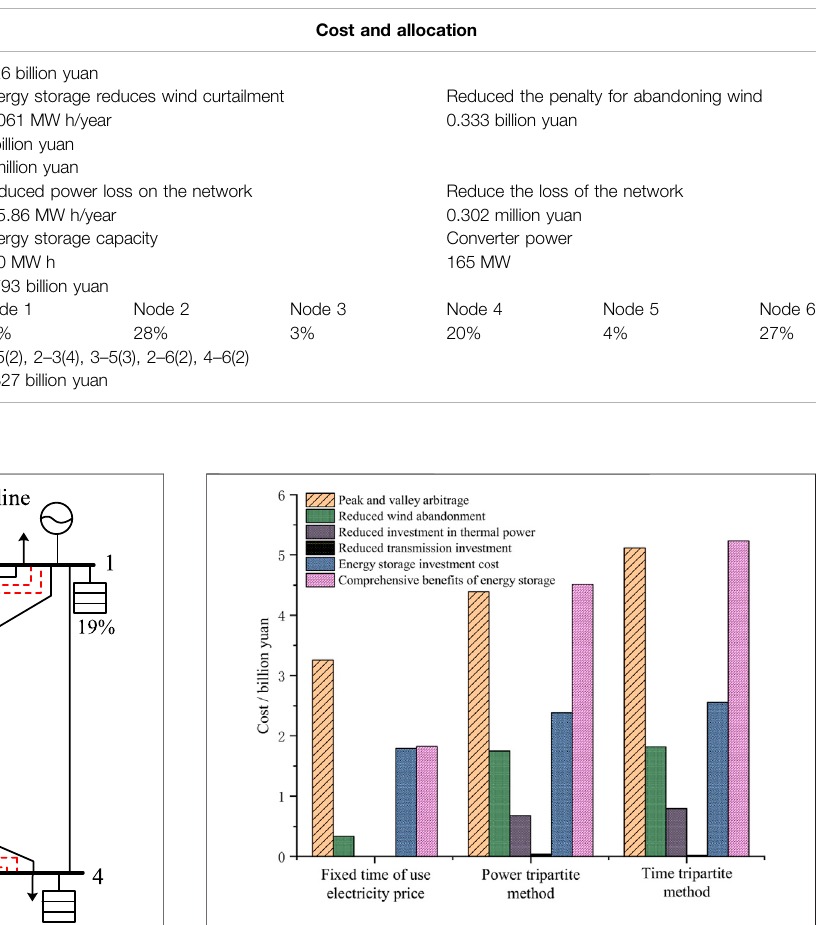
FIGURE 10 | Economic comparison of the three